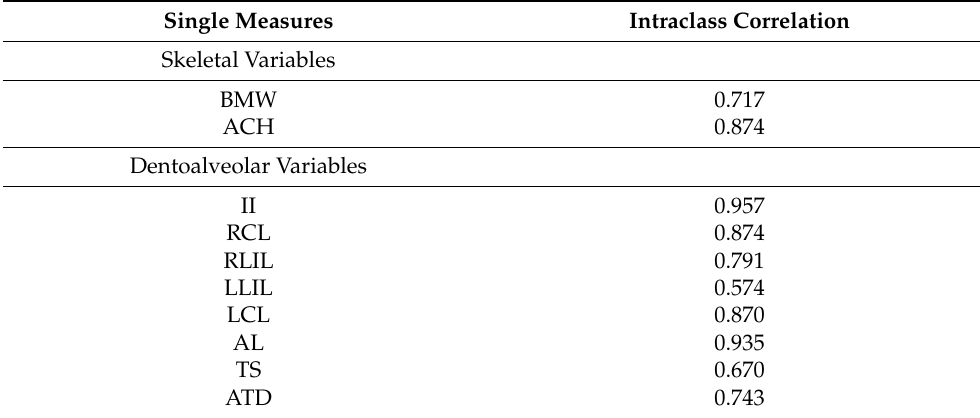
Table 2. Intraclass correlation coefficients for the GC and GI.